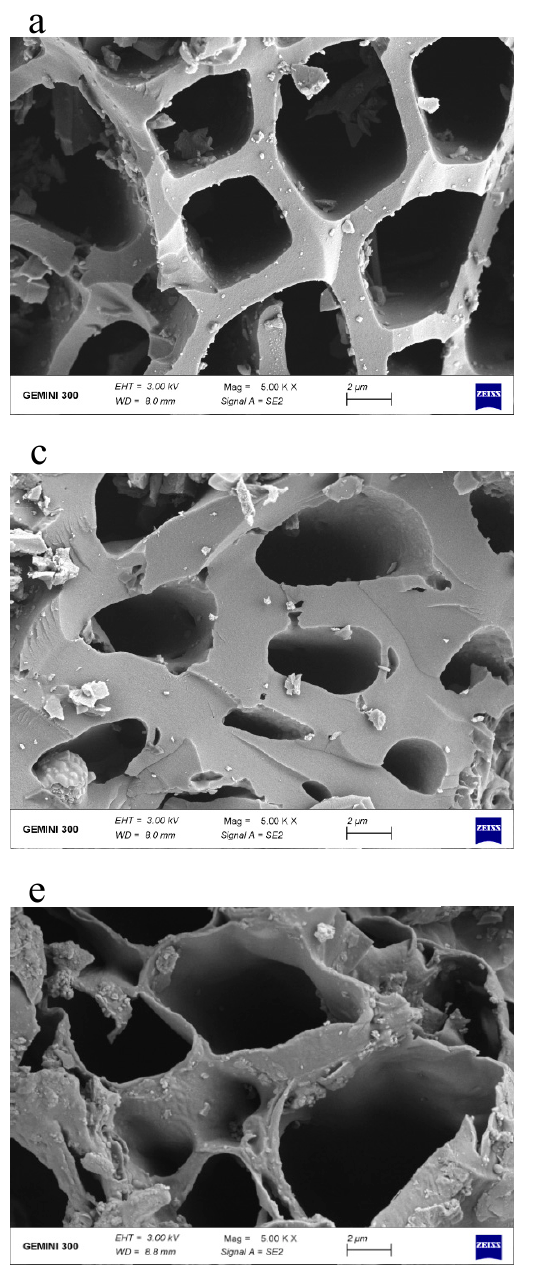
Figure 2. SEM images of unmodified biochars S ( a ), P ( c ), R ( e ) and Fe-B MS ( b ), MP ( d ), and MR ( f ). The FTIR spectra showed similar functional groups between the unmodified and cor- responding Fe-B (Figure 3). The broad peaks at 2949–3191cm − 1 could be attributed to the presence of -CH 2 groups [33], while the small bands at 2865–3050cm − 1 indicated the pres- ence of -CH 3 groups. Further, the peaks at 1388–1430cm − 1 corresponded to the COO- func- tional groups and the visible spectral band with a peak at 1075–1085cm − 1 was contributed by the presence of C-O groups. The broad band in MS, at 3400–3700cm − 1 , indicated the existence of -OH groups enhanced and after modification compared to unmodified bio- chars, confirming the existence of Fe-OH on the surface of Fe-B [34]. The small bands at 2985–2901cm − 1 represented C-H stretching vibrations, while the peak at 1560–1665cm − 1 could be attributed to aromatic C=C stretching vibrations. The peak at 874–833cm − 1 could be attributed to the bending vibrations of C-H outside an aromatic ring, and the increased